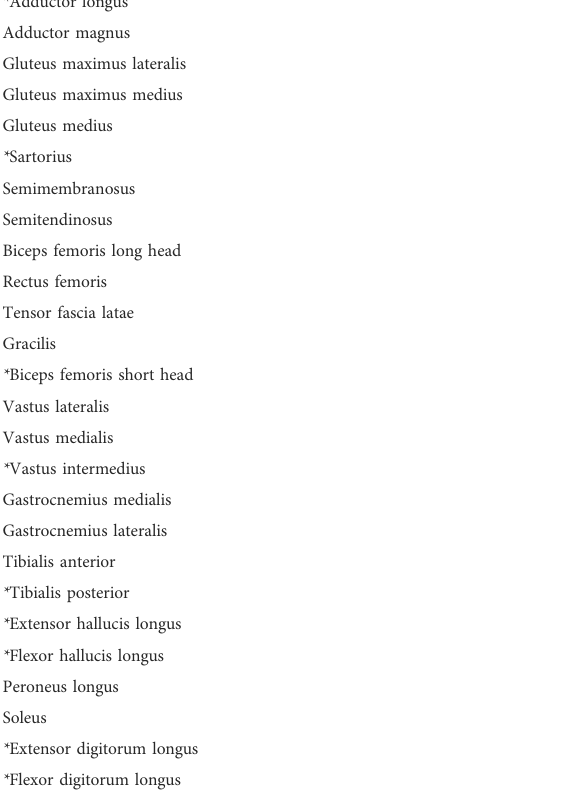
TABLE 1 Right leg muscles from which surface or fi ne-wire (*) EMG data were